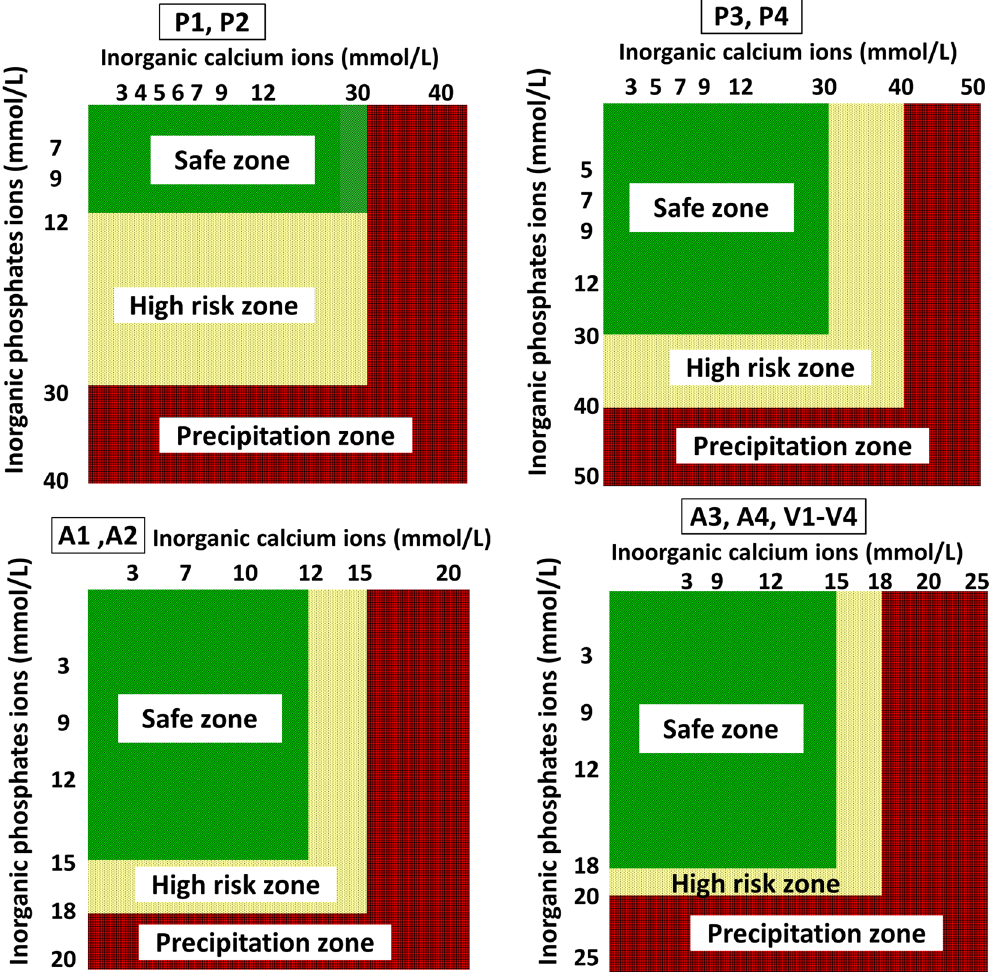
Figure 3. Stability and precipitation zones of PN solution in respect of the concentration of organic and inorganic calcium and organic phosphate ions (t = 24 hr, 37